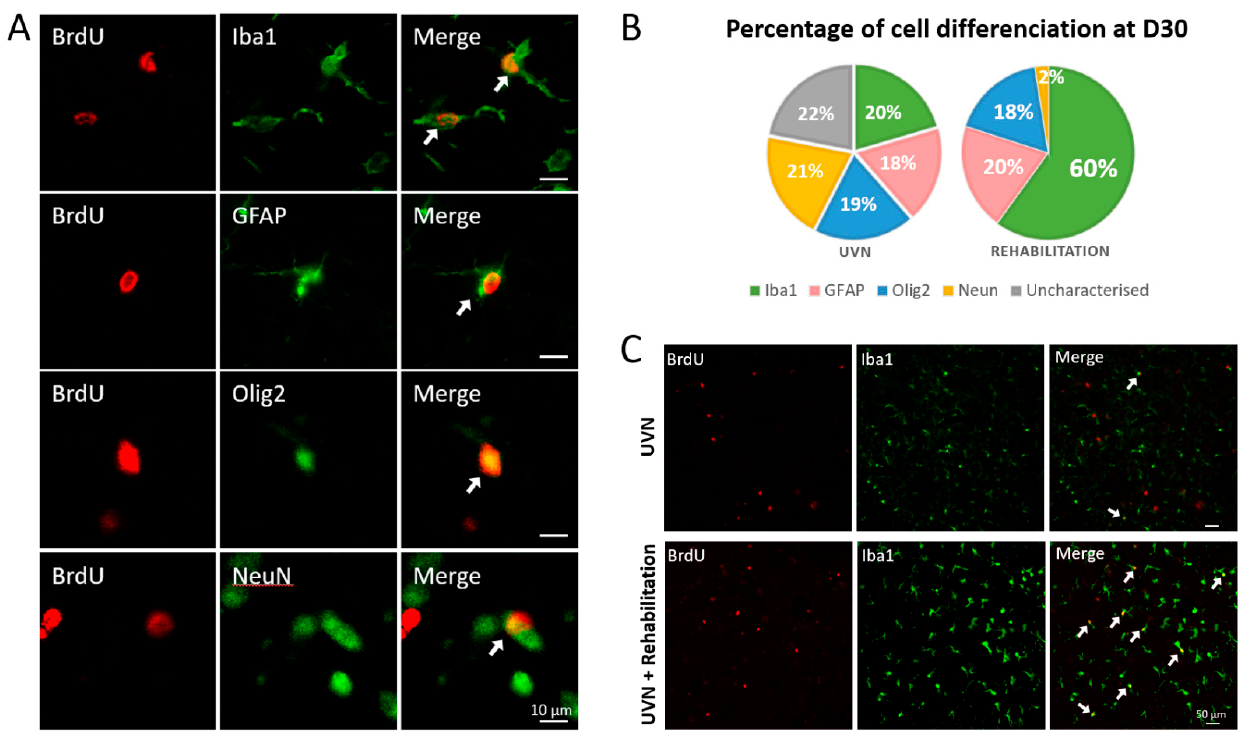
Figure 7. Differentiation of newly generated cells in the deafferented MVN of rats in the UVN and rehabilitation groups 30 days after the injury. BrdU is used as a cell proliferation marker. It is injected 3 days after UVN, and the cell quantification was made on the same rats sacrificed 30 days after UVN. ( A ) Immunostaining images taken with a confocal microscope. BrdU nuclei are marked in red, and cell phenotype markers (Iba1, GFAP, Olig2, and NeuN) are green. ( B ) Pie charts illustrating the percentage of GFAP + , IBA1 + , Olig2 + , and NeuN + cells among the BrdU + cells in the UVN and rehabilitation groups. The percentages are globally balanced in the UVN group (about 20% for each cell type and 20% of uncharacterised cells). The rehabilitation group favours a microglial differentiation phenotype (60%), and the proportion of newly formed neurons is very low (2%). ( C ) double immunostaining images taken with a confocal microscope in the deafferented MVN of the UVN group (upper part) and the rehabilitation group (lower part). The BrdU + nuclei are shown in red, and the Iba1 + cells are shown in green. We show here that the rehabilitation protocol increases the microgliogenesis compared to the UVN untrained group (see white arrows).